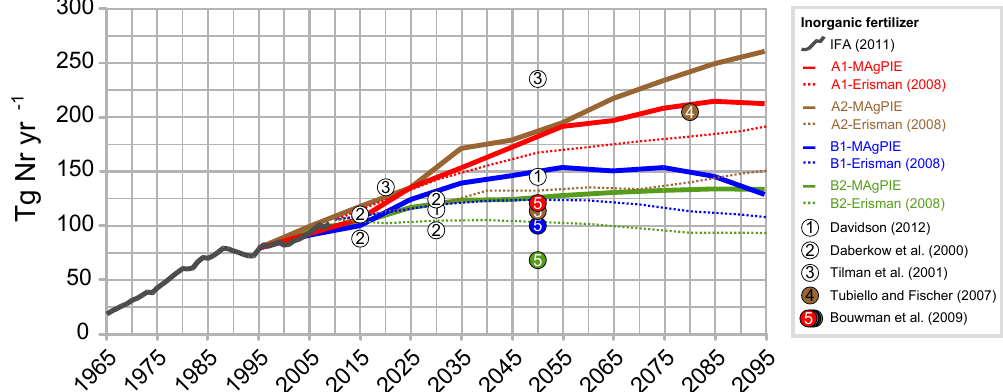
Fig. 3. Fertilizer consumption: historic dataset of IFADATA (2011), SRES scenario estimates by Erisman et al. (2008), Bouwman et al. (2009), Tubiello and Fischer (2007) and our study, as well as other estimates by Davidson (2012), Daberkow et al. (2000) and Tilman et al.